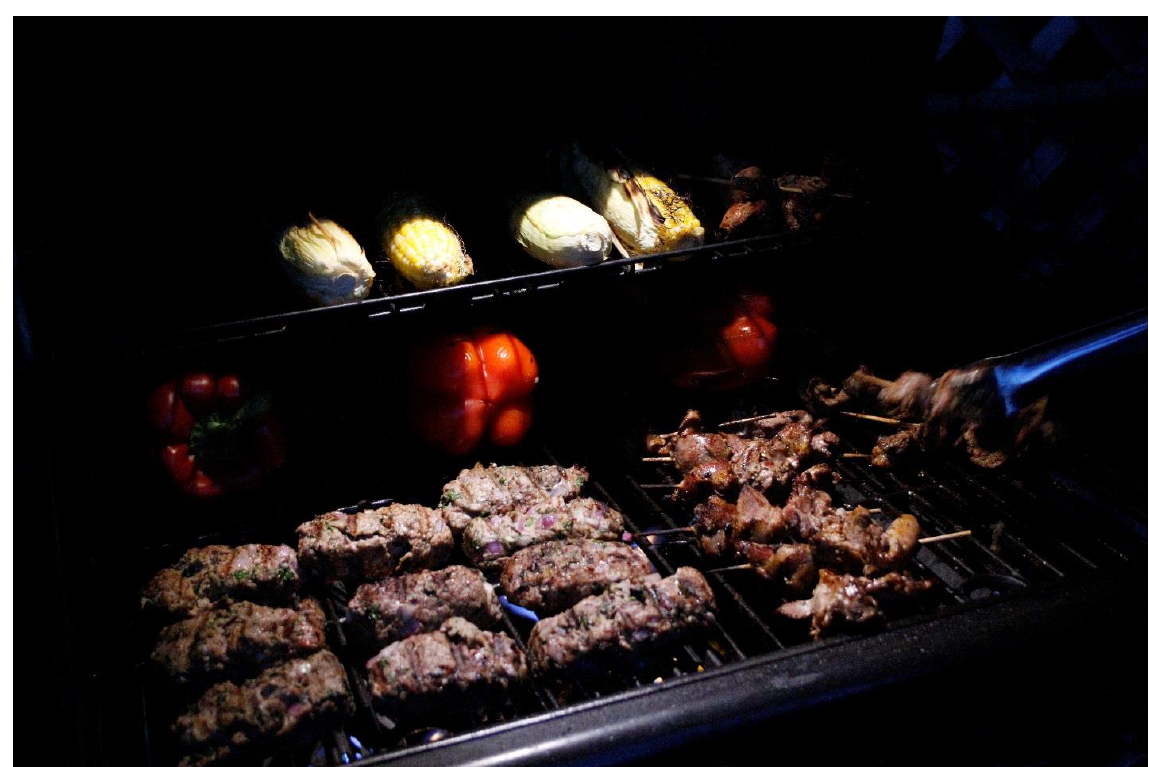
Figure 6. Goat sausage and kebabs. (Photo by Amy